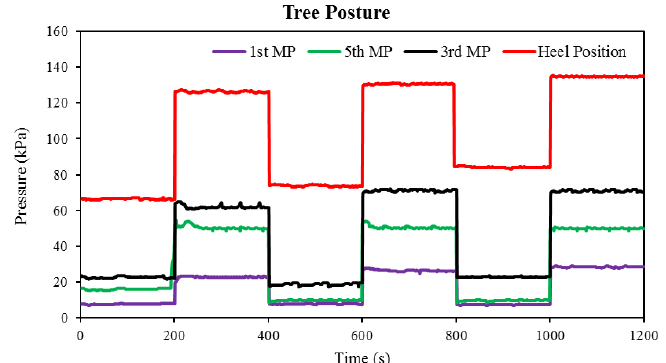
Figure 5. The pressure changes in Flexi force sensors against time during the tree posture.